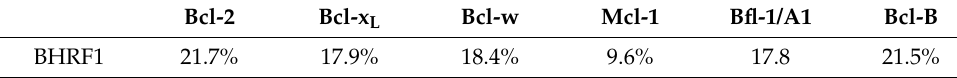
Table 2. Percentage sequence identity of BHRF1 with its mammalian